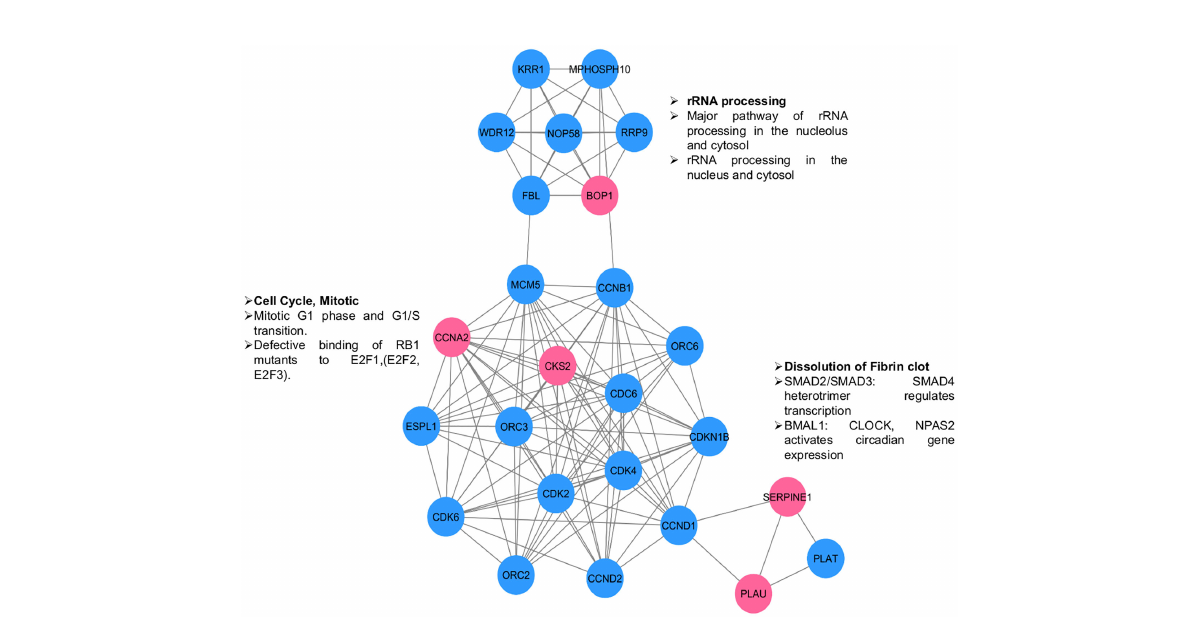
FIGURE 6 PPI network for selected genes (pink circles) to understand their interactions & signi fi cance. Other interacting proteins are depicted in blue circles. Three clusters are visible. The enriched functions are shown along the